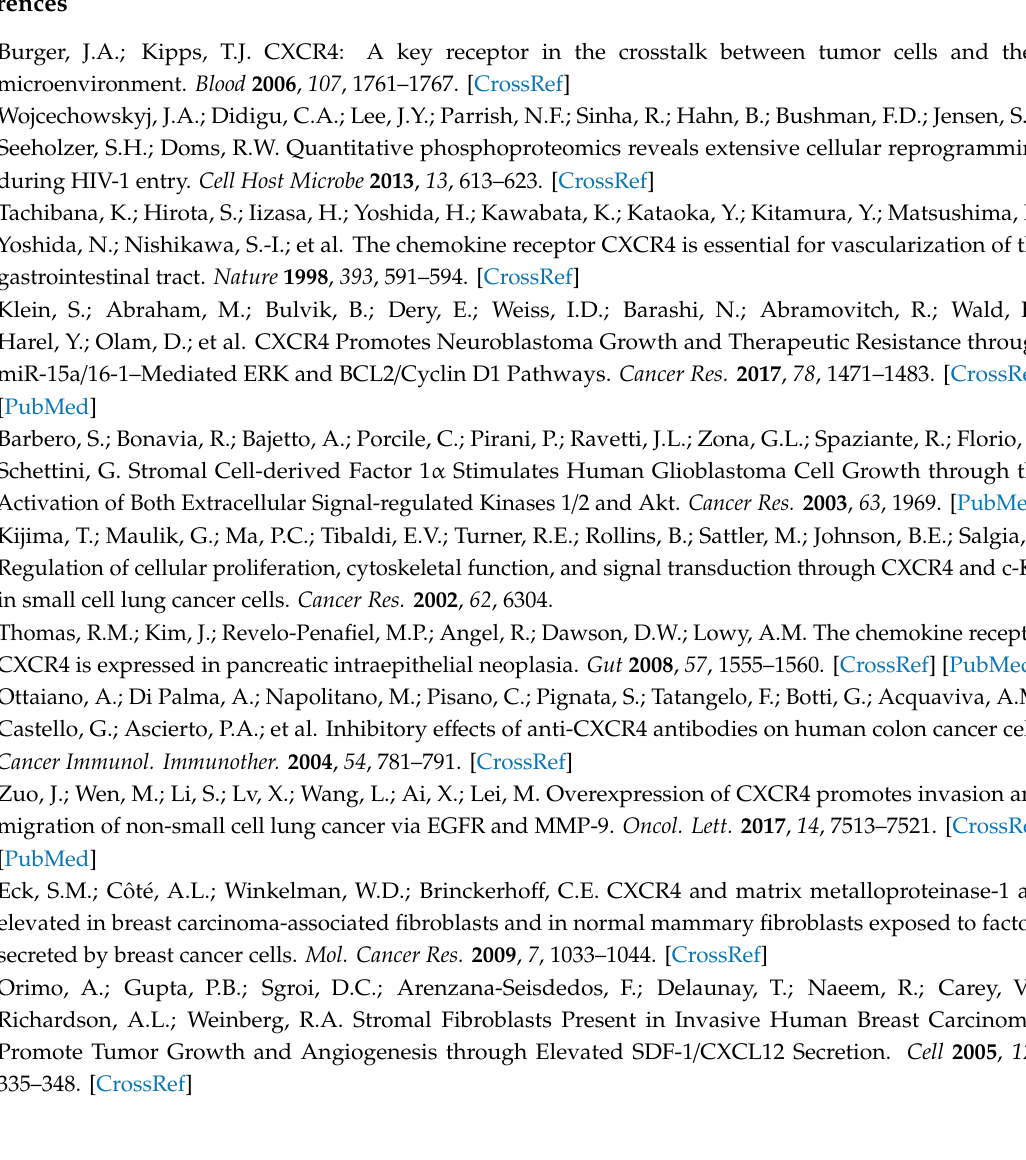
Figure S1: Normalized CXCR4 FPKM values from CRC patients categorized by tumor stage, Figure S2: UCSC Genome Browser (hg19 build) depiction of CXCR4 containing 2 CpG islands (green) and 3 Methyl 450K probe sub tracks for colorectal cell lines Caco2 and HCT116 (Probe colors of Blue = unmethylated, Purple = partially methylated, and Yellow = fully methylated), Figure S3: Full-length COBRA images from Figure 2a (T tumor, C control), Figure S4: Full-length COBRA images from healthy control patients from Figure 2b (H# human subject number; P proximal colon, D distal colon), Table S1: Clinical characteristics and statistical analysis of patients used in the qPCR studies, Table S2: Densitometry statistics of CXCR4 bands in Figures 1c and 4d. Table S3: Clinical characteristics of patients used in the COBRA analysis in Figure 2 and Figures S3 and S4. Table S4: Number of patients deposited in TCGA that were used in the CXCR4 RNA-seq and 450K methylation microarray analysis. Author Contributions: All authors have read and agree to the published version of the